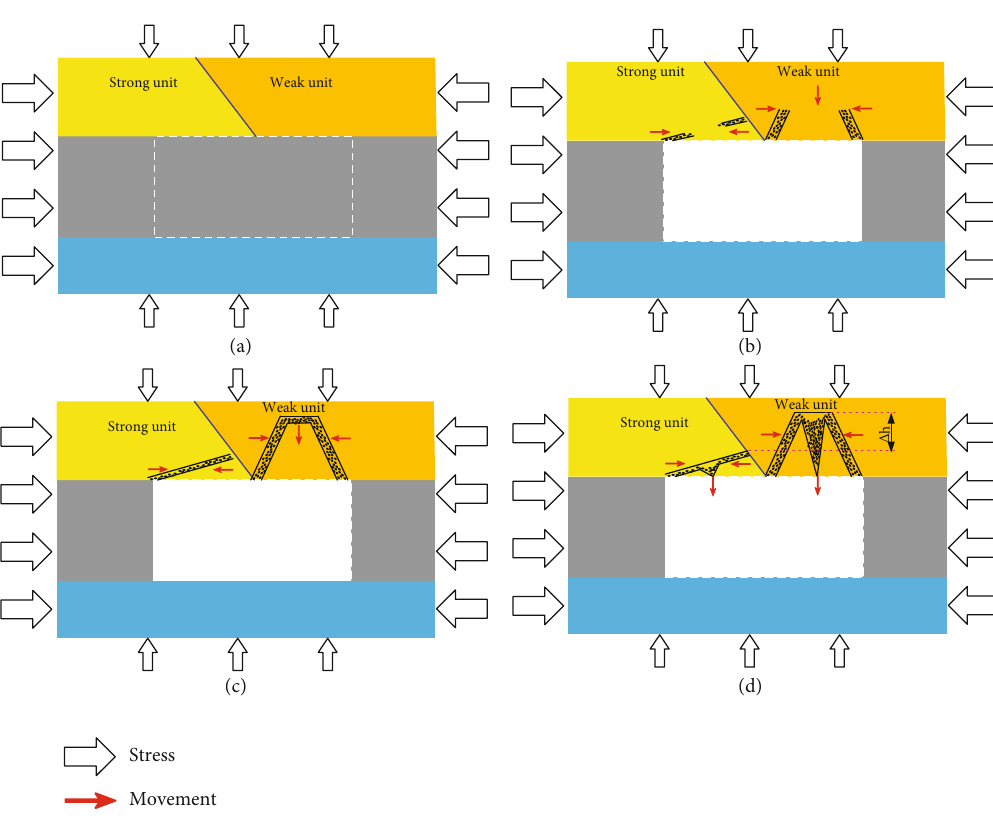
Figure 16: Schematic diagram of progressive asymmetrical instability of roof of large-span roadway with discontinuous surface ( Δ h is the di ff erence of roof fracture height between regions I and II).